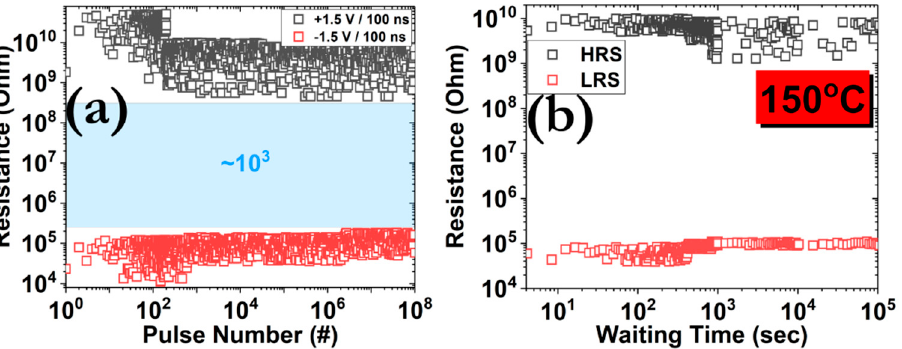
Figure 4. ( a ) Pulse endurance measurements under the application of ± 1.5 V/100 ns and ( b ) retention measurements at 150 °C (read voltage pulse 100 mV/100 ms).